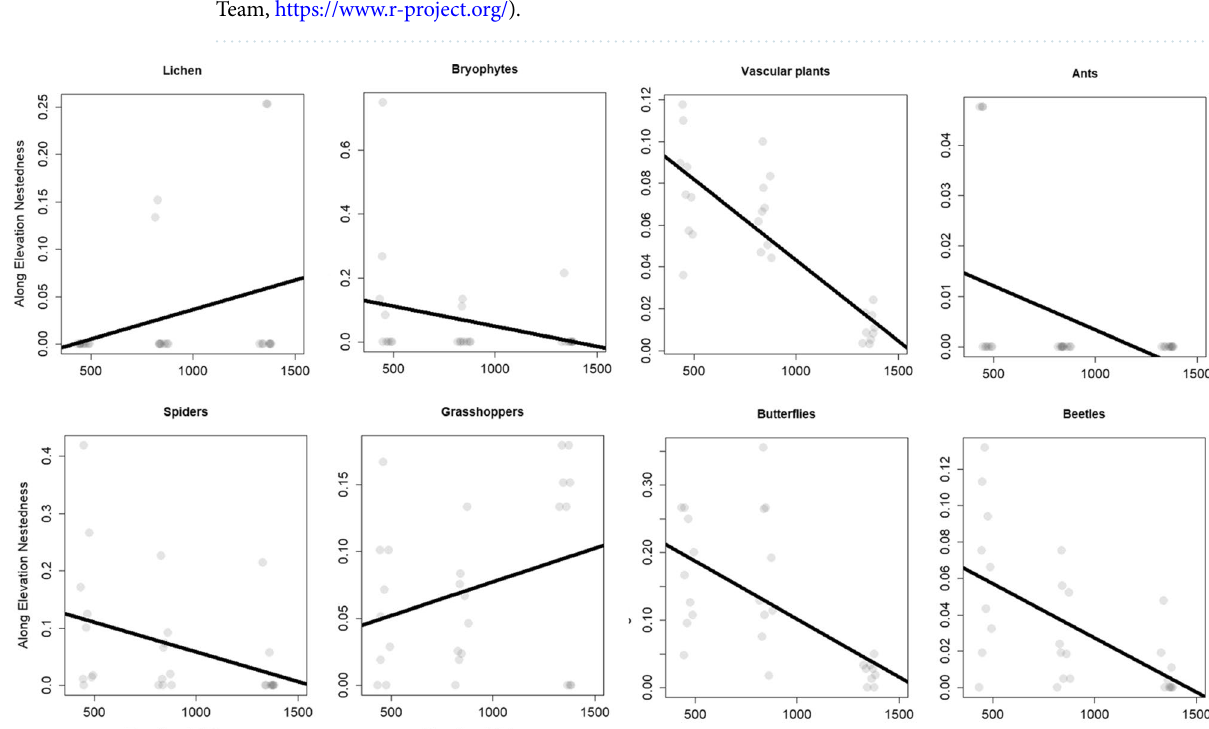
Figure 4. Along elevation nestedness: the effect of elevational distance on nestedness was tested with a linear mixed effects model. As fixed effects, we tested the elevational distance, as random effects the elevational replicate sites were modelled. The line indicates the response of nestedness to elevational distance, grey points display nestedness values of pair-wise comparisons. Figure was produced using R software (version 3.6.2, R Core Team, https ://www.r-proje